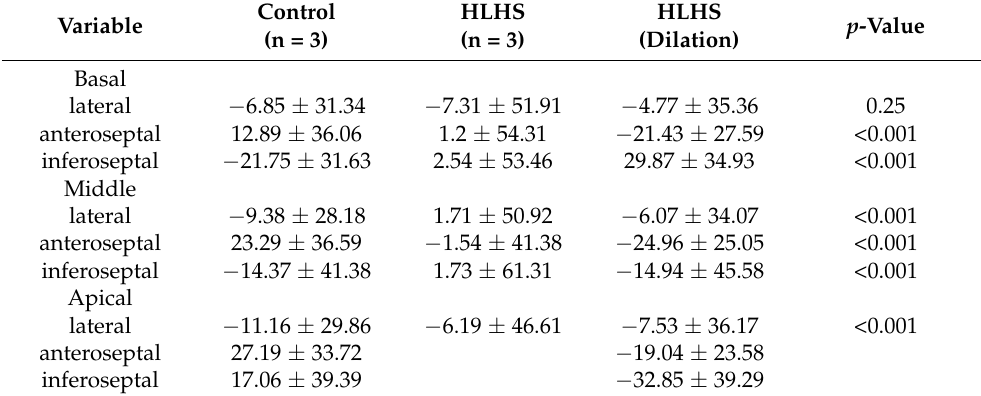
Figure 3. ( A ) MD map in normal fetuses. ( B ) MD map in HLHS fetuses. ( C ) MD values decreased in HLHS fetuses. Table 7. Regional characteristics of the helix angle gradient in the right ventricle in HLHS and control specimens at 24~30 gestational